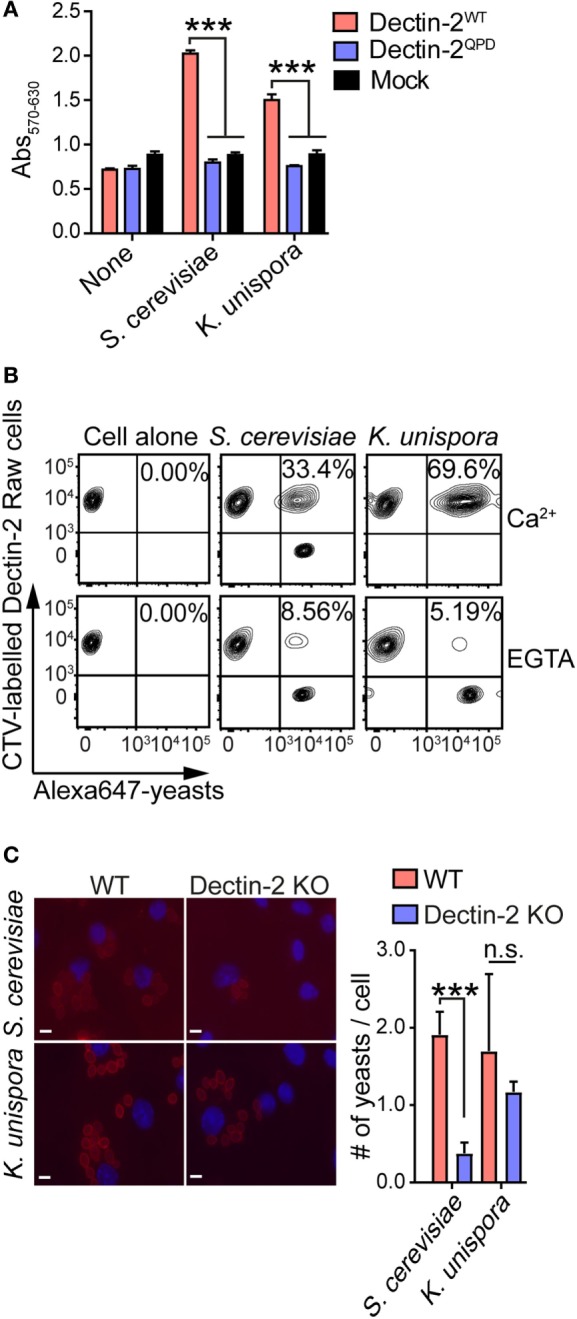
Mouse Dectin-2 binds to gut commensal yeasts. (A) BWZ reporter cells expressing mouse Dectin-2WT, Dectin-2QPD, and mock transfectant were incubated with the indicated yeasts at a MOI of 5. After 1 day incubation, β-galactosidase activity in the reporter cells was monitored by a colorimetric assay. (B) Mouse Dectin-2-expressing RAW macrophages were incubated with Alexa647-labeled yeasts or left alone. The binding was analyzed by flow cytometry. (C) Mouse BMDCs were incubated with the Alexa555-labeled and paraformaldehyde-fixed yeasts (red) at a MOI of 10. After 2 h incubation, images of BMDCs were taken with the DAPI staining (blue). White bar indicates 5 µm. The number of yeasts associated with BMDCs was quantified. Data shown are the mean of triplicates ± SD from one representative experiment and reproducible in three independent experiments. Statistical analyses were performed by one-way ANOVA followed by Tukey’s test. *p < 0.05; **p < 0.01; ***p < 0.001; n.s., not statistically significant.